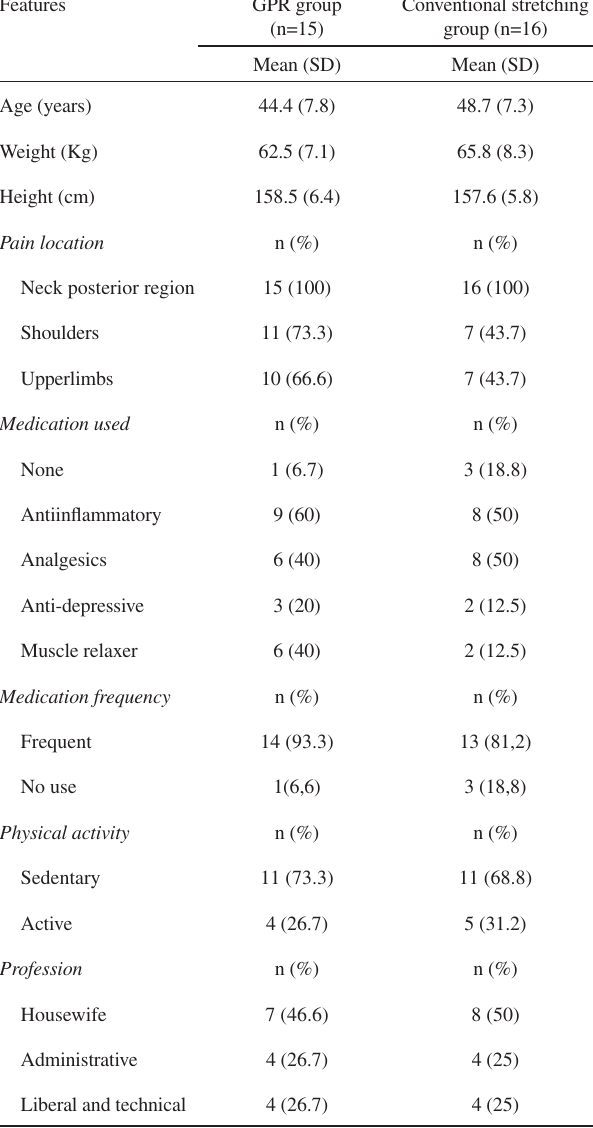
Table 1 - Patients’ clinical and demographic data, according to group